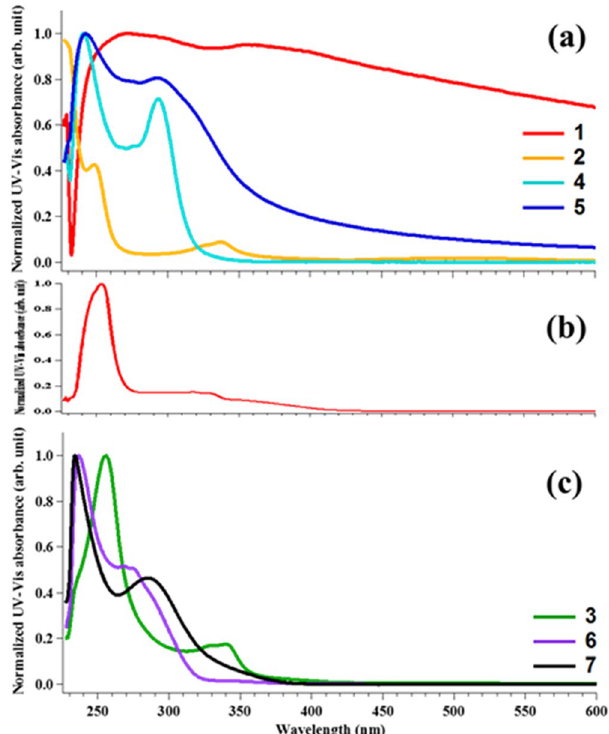
Figure 2. UV-Vis absorption spectrum of Au(I) series, 1 , 2 , 4 , and 5 in PBS ( a ), 1 in CHCl 3 ( b ), Au(III) series, 3 , 6 , and 7 in PBS ( c ). Concentration of complexes = 50 μ M. DMSO was used for stock solution. (The final concentration of DMSO was 1% of the total